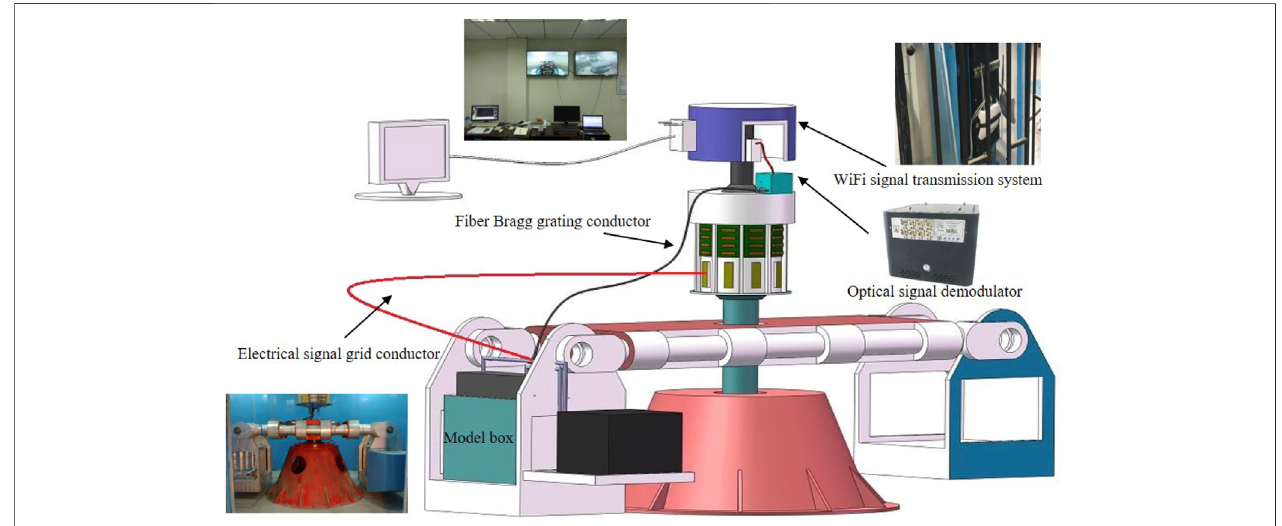
FIGURE 1 | Geotechnical centrifuge of Chang ’ an University.